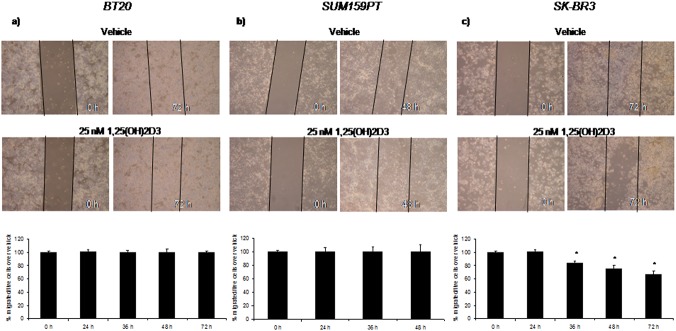
Vitamin D wound healing assay.Upper part: representative micrographs of wound healing closure assays from BT20 (a), SUM159PT (b) and SK-BR3 (c) cells, treated as indicated for 48–72 hrs. Lower part: histogram showing the healing closure efficiency of the cells treated with vehicle or 25 nM 1,25(OH)2D3 at the indicated times. Bars indicate the average of three independent experiments. * p-value < 0.05.